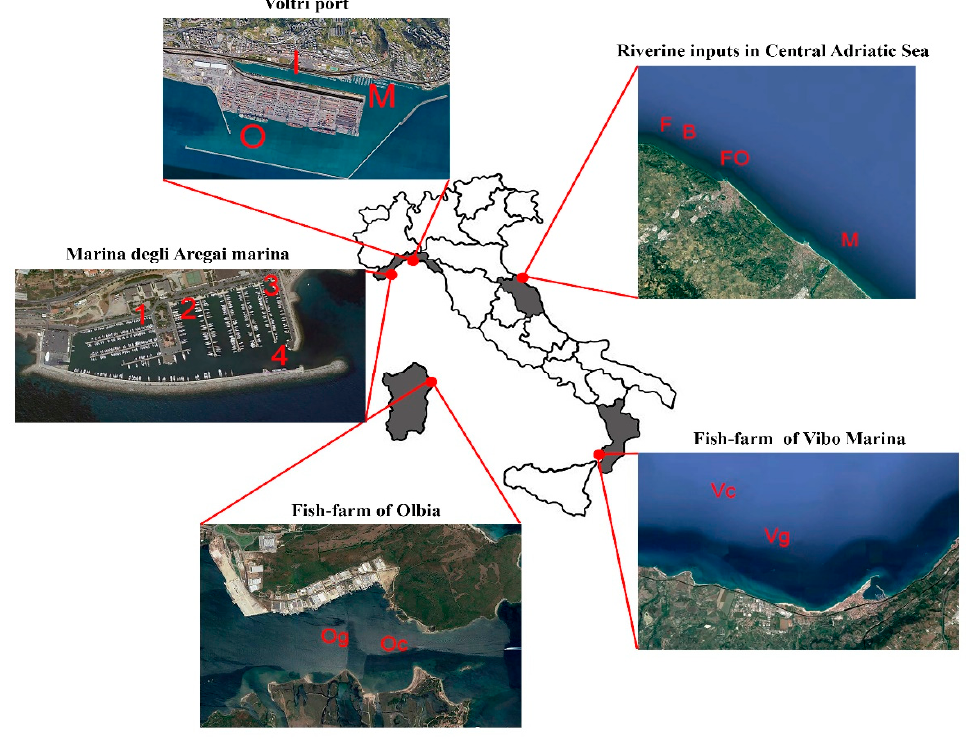
Figure 1. Localities of the study cases considered in the present study. Port contaminated stations: Voltri (St. I: inner port area, St. M: central port area, and St. O: outer port area) and Marina degli Aregai (four stations from the inner, St. 1, to outer port part, St. 4); coastal sediments influenced by riverine inputs (St. B and St. FI: Natural Regional Park; St. M and St. FO: Foglia and Metauro rivers); fish farm of Olbia (Og: under cages, Oc: controls) and tuna farming of Vibo Marina (Vg: under cages, Vc: